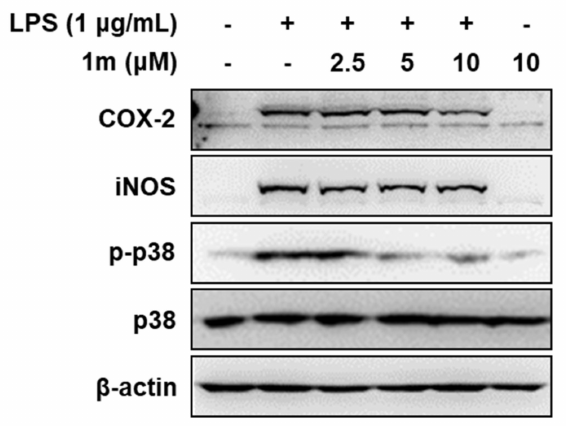
Figure 4. Effect of compound 1m on COX-2, iNOS, and p-p38 protein expression in LPS-induced RAW 264.7